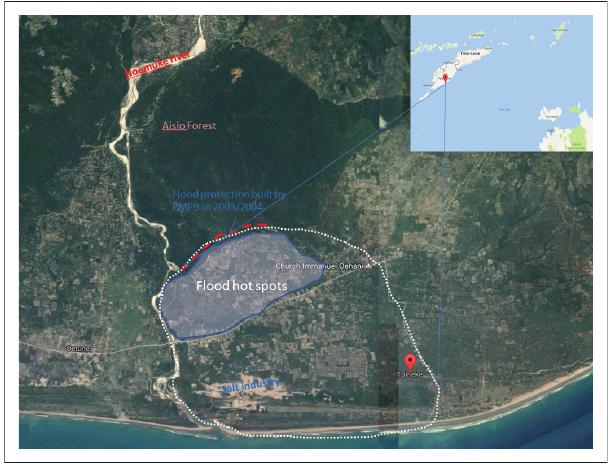
FIGURE 2: Toineke village in geographical context.